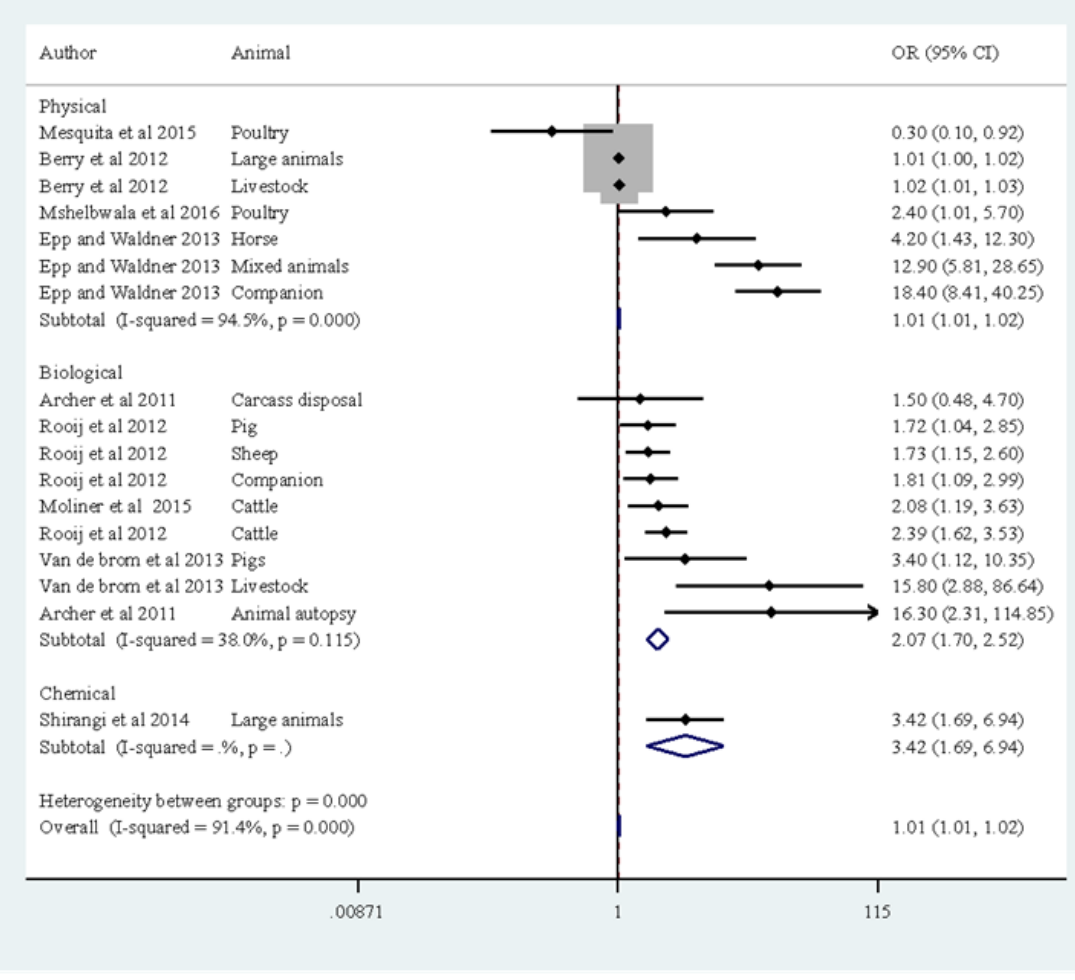
Figure 6 Forest plot of pooled odds ratio estimate of working or contact with animals as a risk factor for occupational hazards among